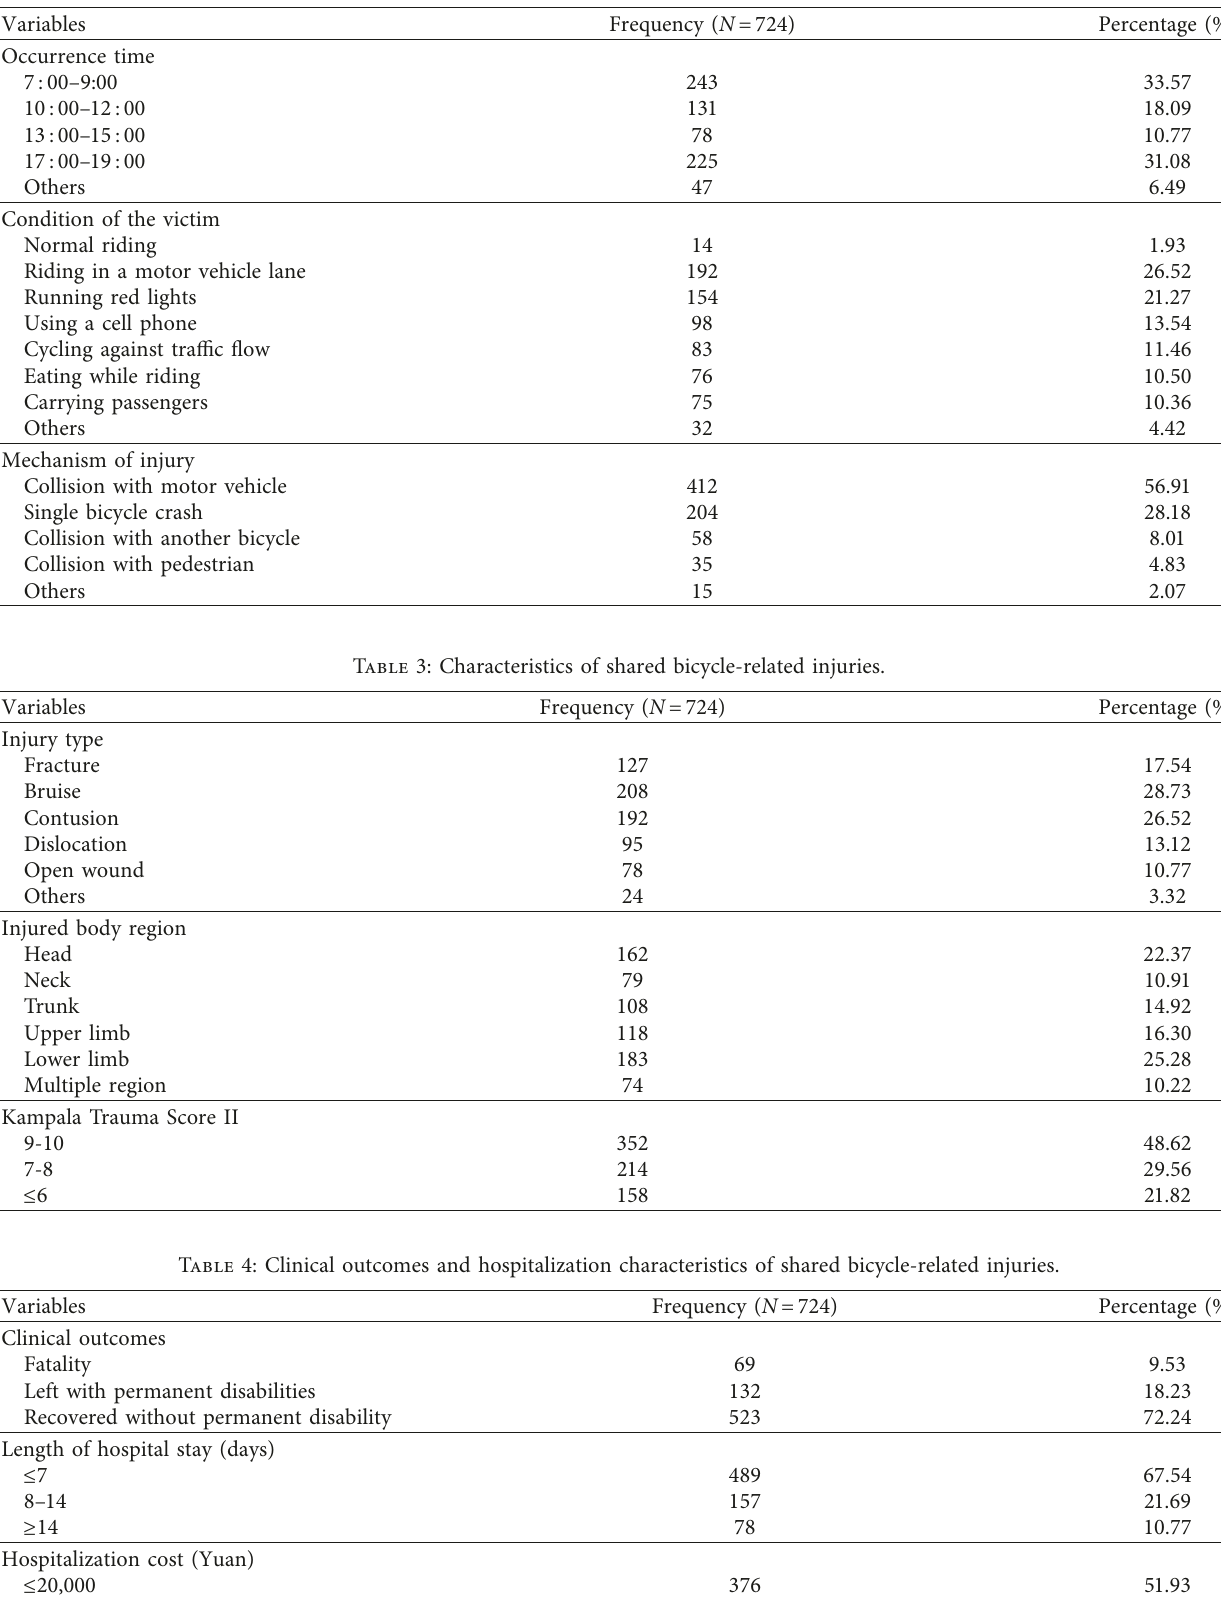
Table 2: Time and conditions of the victims during the occurrence of shared bicycle-related injuries.